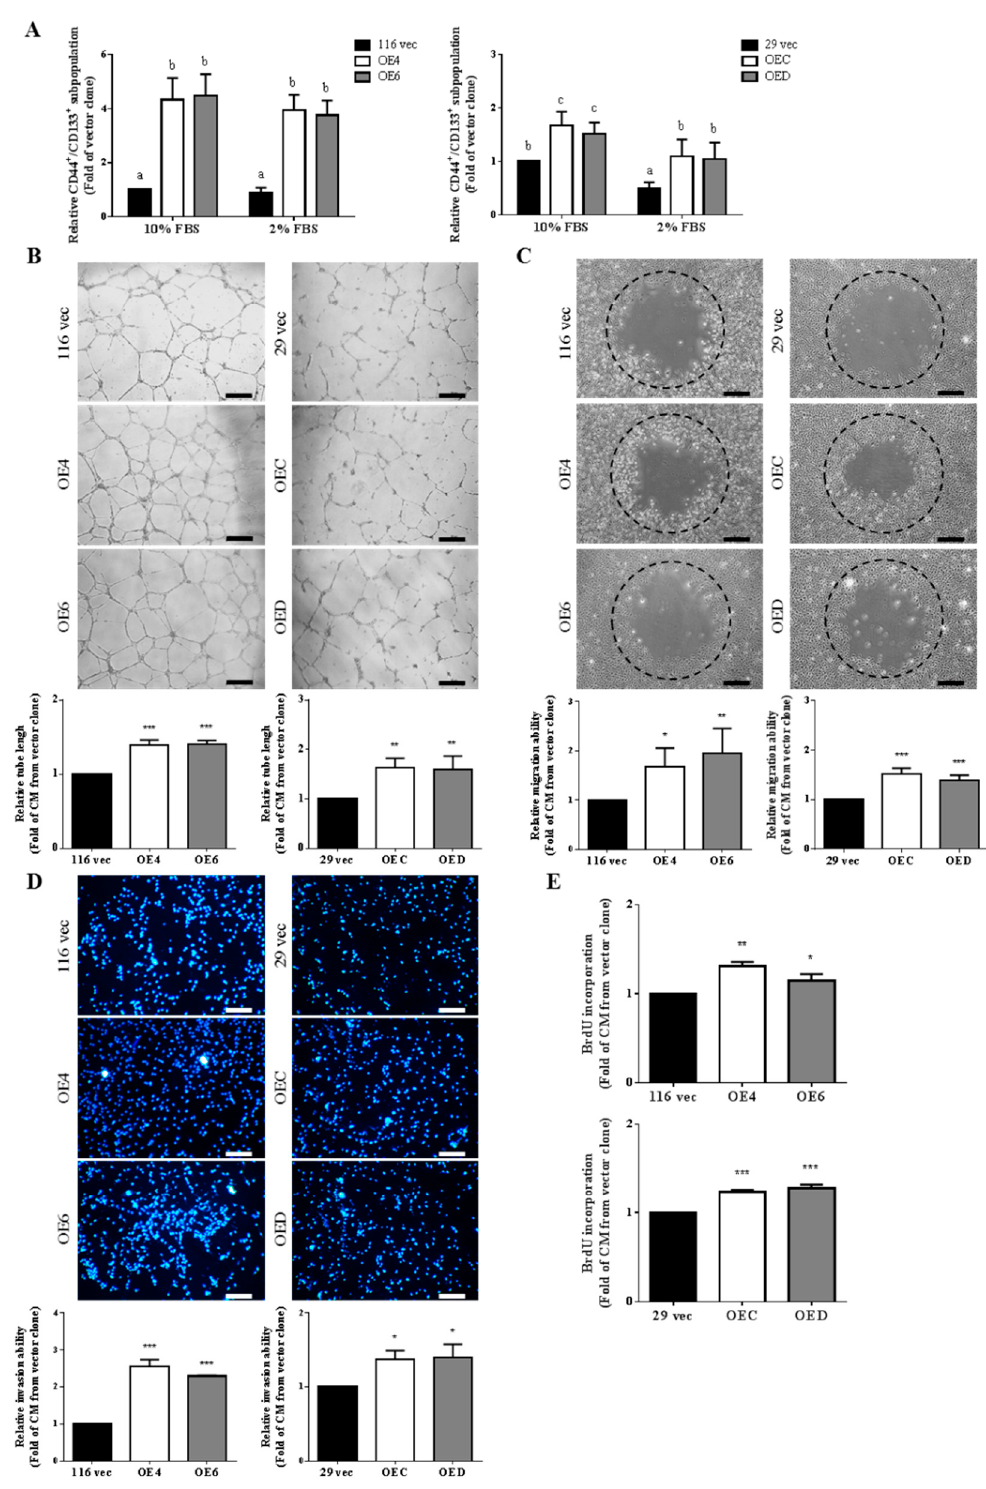
Figure 1. Conditioned media (CM) collected from stemness-high human colorectal cancer cells induce a stronger angiogenesis of endothelial cells. ( A ) The percentages of CD44 + /CD133 + subpopulations in the vector and the GATA6-overexpressing HCT-116 (116 vec, OE4, and OE6) (left) as well as HT-29 (29 vec, OEC, and OED) (right) clones after being cultured in the media containing 10 and 2% FBS, respectively, for 48 h were measured by flow cytometry after cells were incubated simultaneously with the FITC-conjugated anti-CD44 and PE-conjugated anti-CD133 antibodies. Data (mean ± SD, N = 3) were analyzed by one-way ANOVA with the LSD post hoc test and different letters (a–c) represent different levels of significance ( p < 0.05). ( B ) HUVECs were suspended in the working media prepared as described in the “Materials and methods” using CM